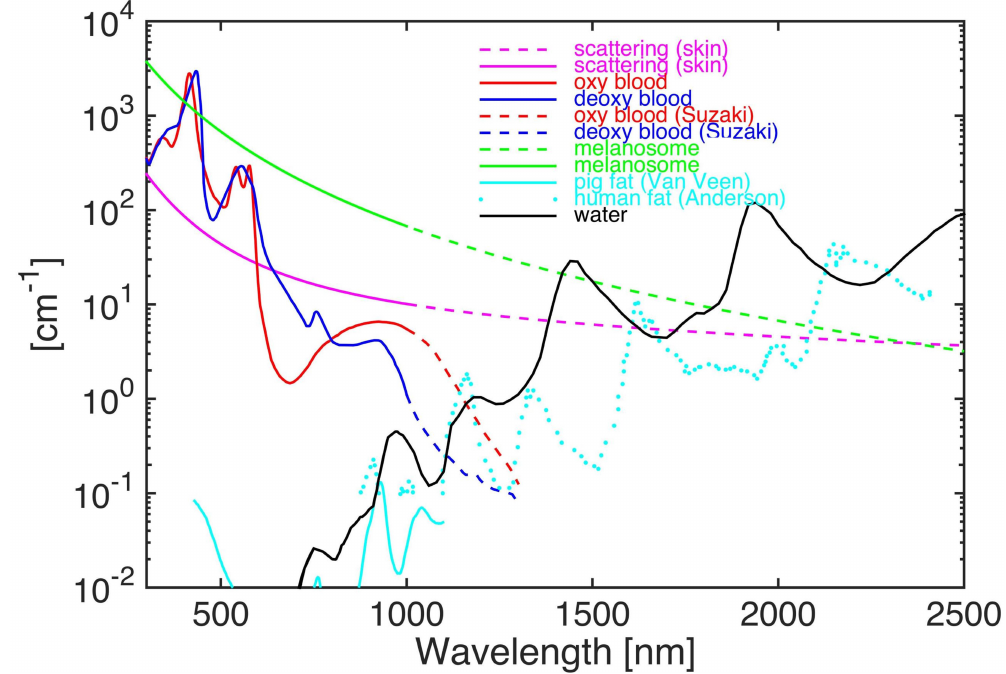
Figure 1. Absorption coefficient spectra of chromophores (water, oxygenated hemoglobin, deoxygenated hemoglobin, melanin, and fat) as a function of optical wavelengths [37]. Adapted from [37] ref.